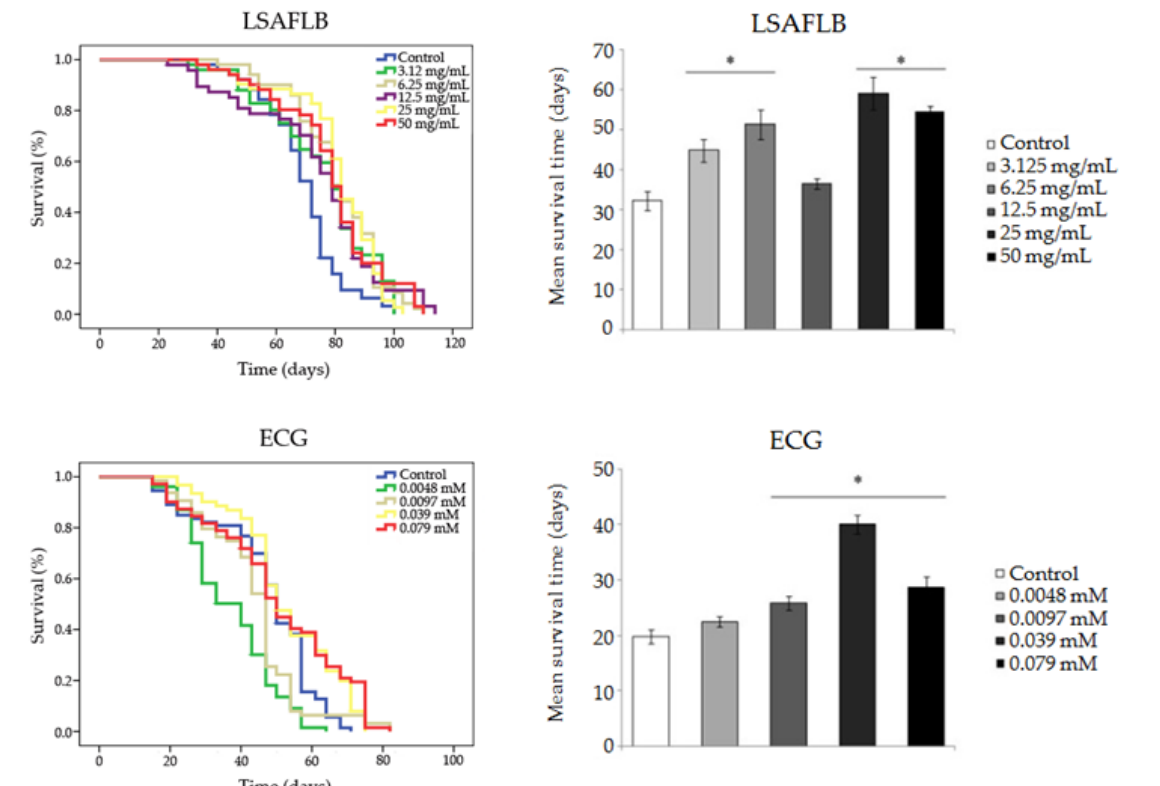
Figure 3. Survival parameters of D. melanogaster fed with different concentrations of lyophilised blond alcohol-free lager beer (LBAFLB), lyophilised pale-blond alcohol-free lager beer (LPBAFLB), lyophilised stout alcohol-free lager beer (LSAFLB) and epicatechin gallate (ECG). ( A ) Survival curves and ( B ) healthspan averages. ( A ) Survival curves of D. melanogaster . ( B ) Mean of survival time in the highest 75% of surviving population. * indicates significant differences ( p < 0.001) compared to the control.